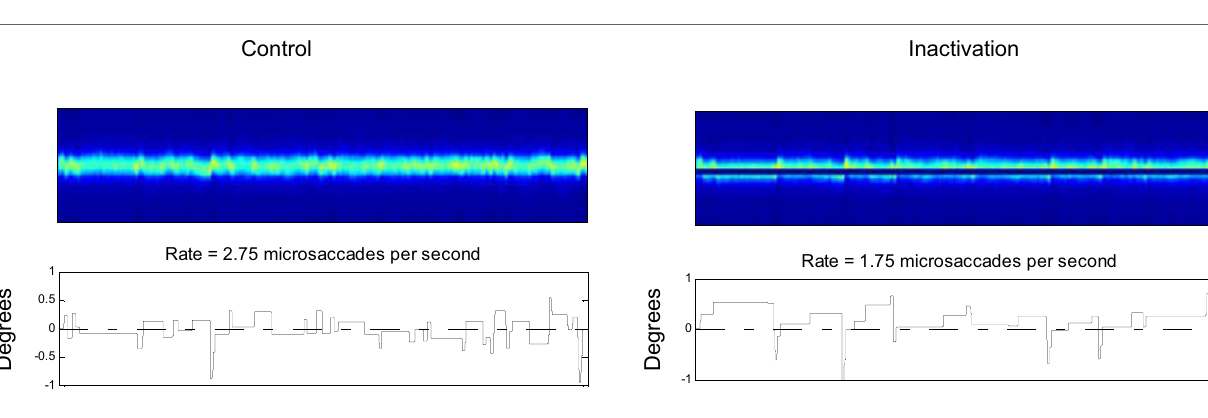
FigUre 8 | Effects of superior colliculus (SC) inactivation. Left: 20 s of a control simulation. Right: 20 s of a simulation where the output of a set of rostral SC neurons was inactivated. The two top panels indicate the SC activity, and the two bottom panels the corresponding eye positions.